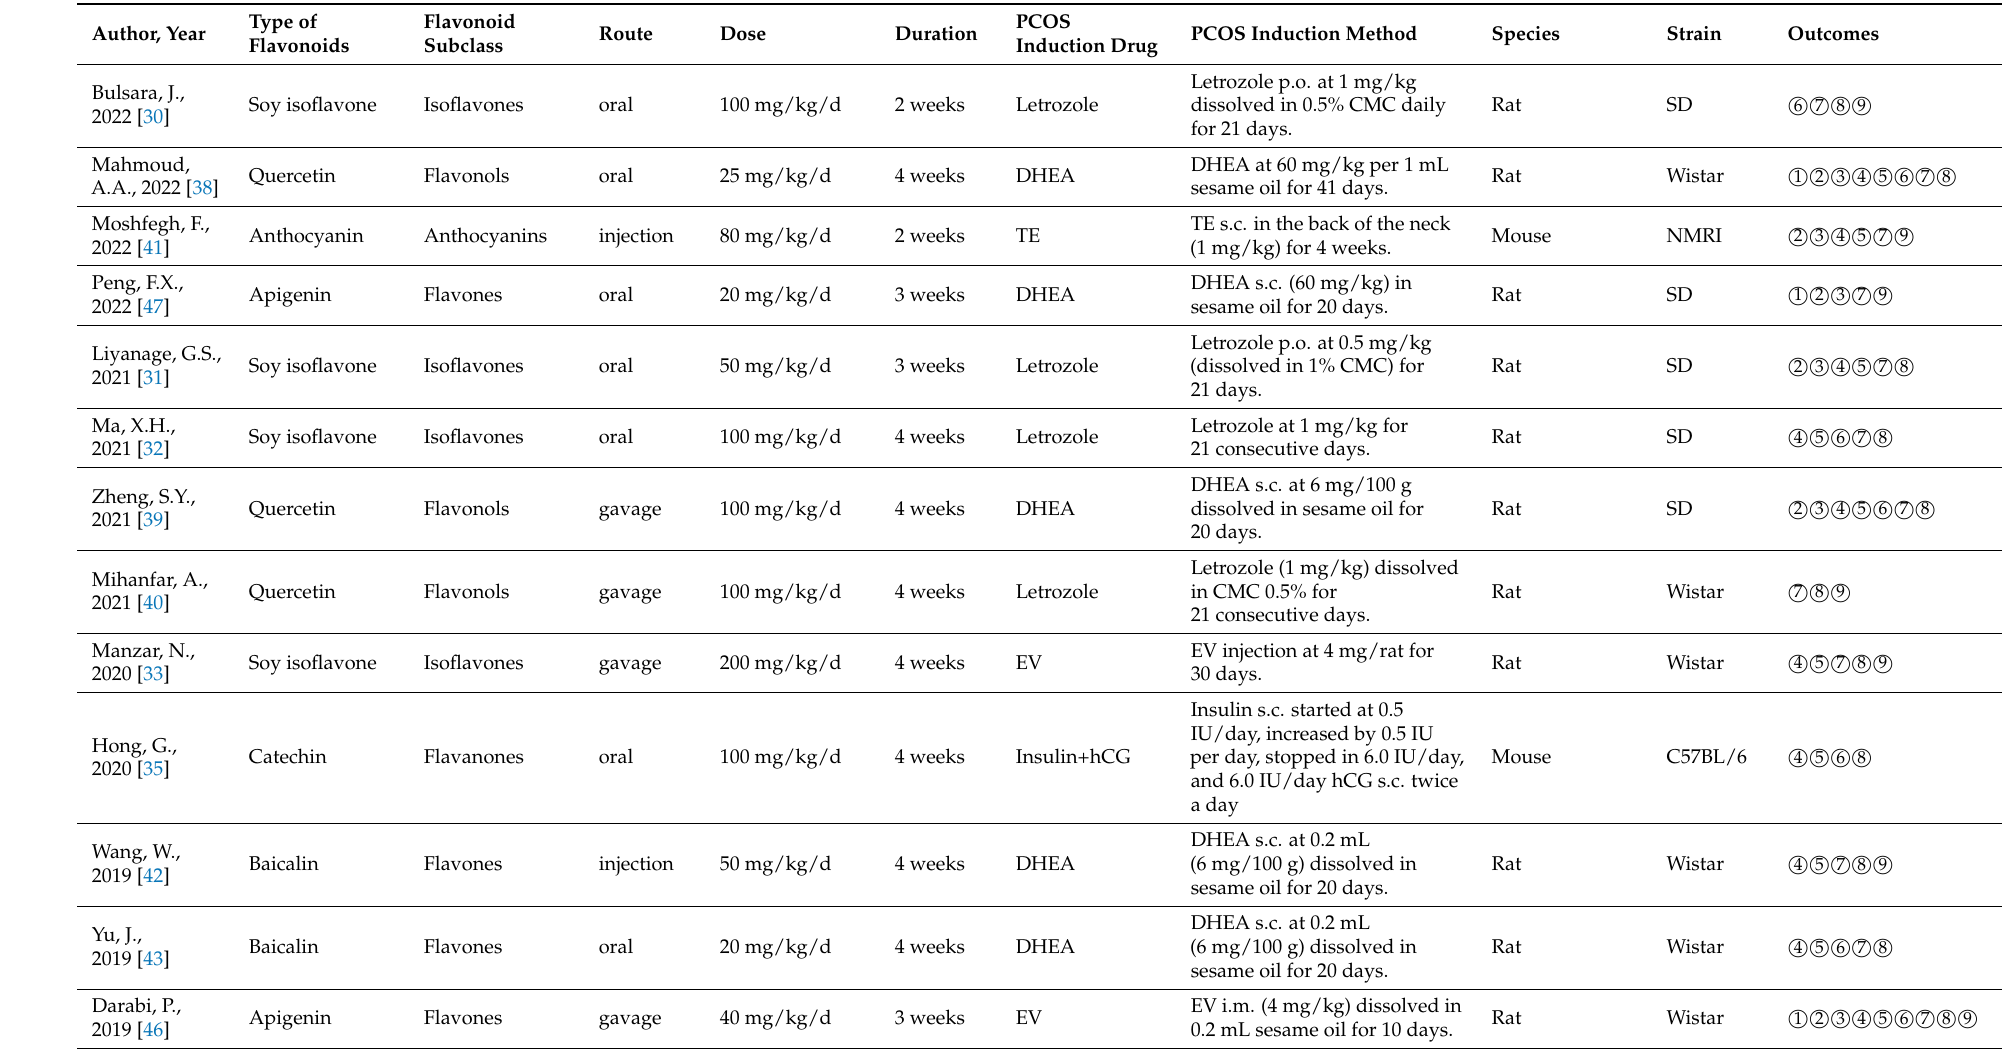
Table 1. Characteristics of 18 included